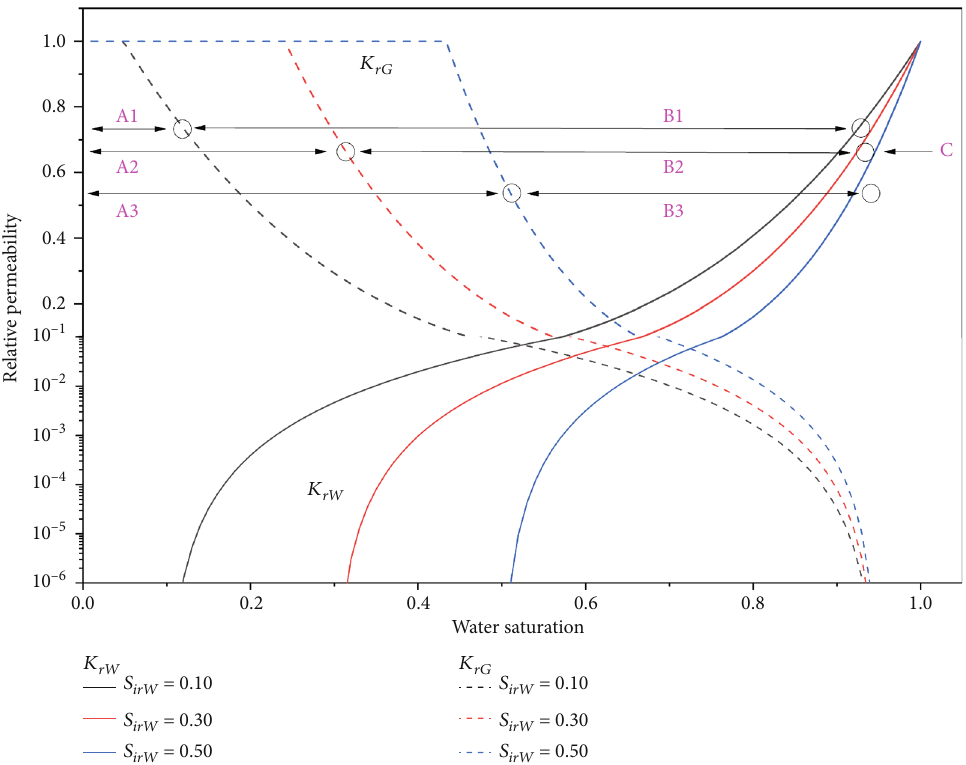
Figure 6: Relationship between gas, water relative permeability, and water saturation in di ff erent cases with di ff erent irreducible water . saturation S irW